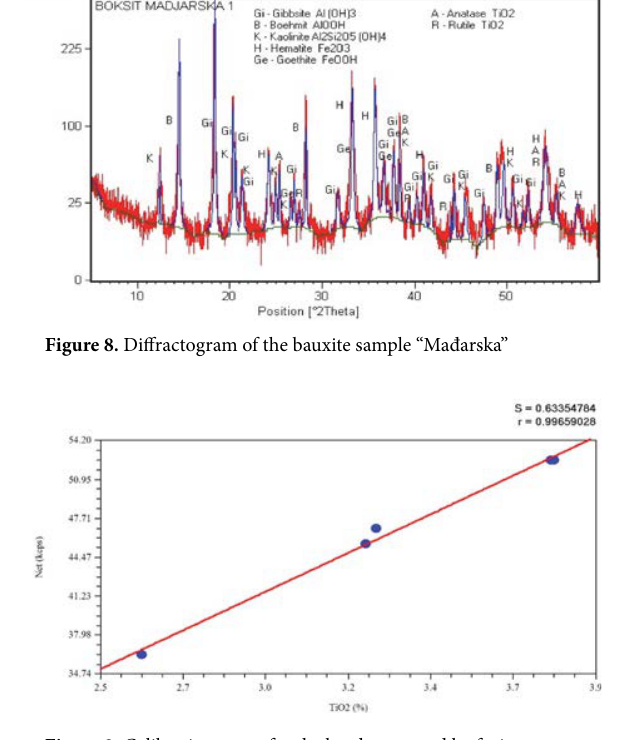
from fusion, Eq. (1):